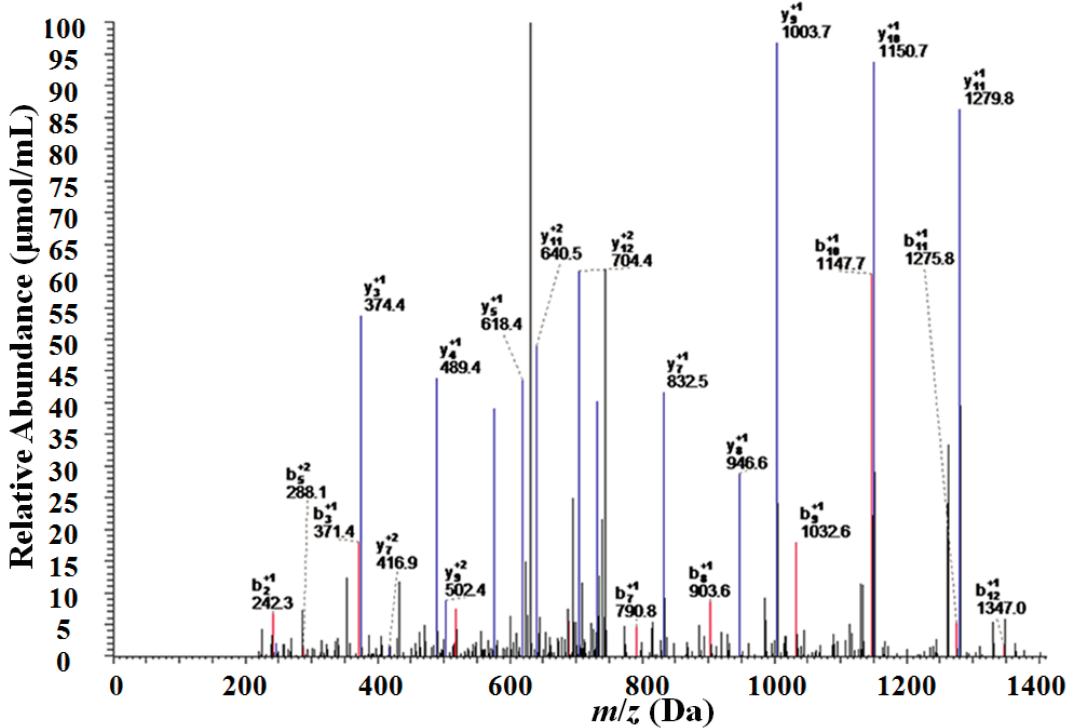
Figure 5. Mass spectrographs of the peptide segments obtained after enzymatic digestion of the proteins and peptide segments with m / z of 6438 Da.